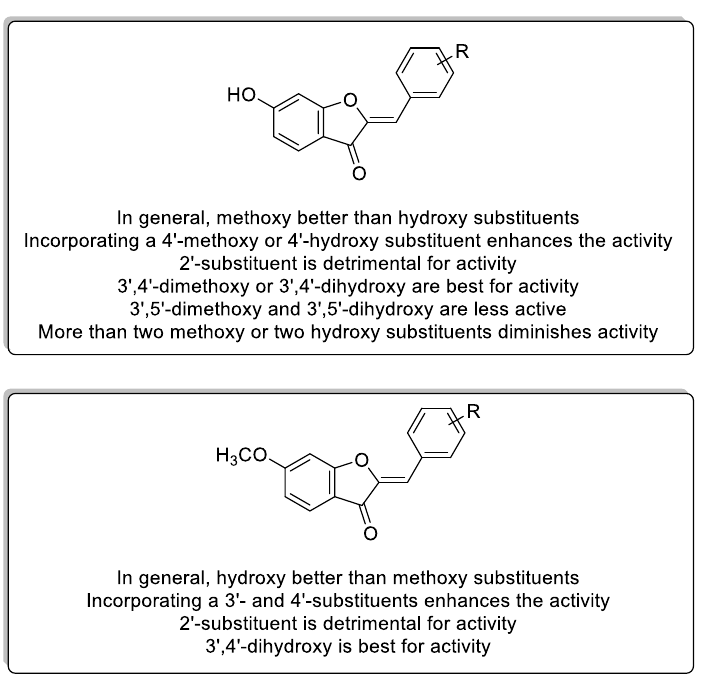
Figure 2. Summary of the revealed structure – antileishmanial activity relationship for evaluated sulfuretin analogs.